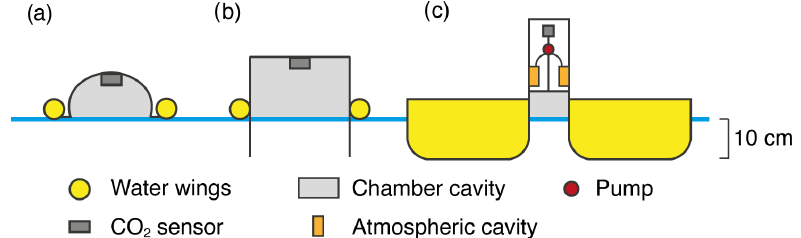
Figure A2. (a) Classical floating chamber; (b) floating chamber with 10cm long-edges; (c) platform design used in this study: 10cm long- edges, rounded-edges, and flat and long water wings.